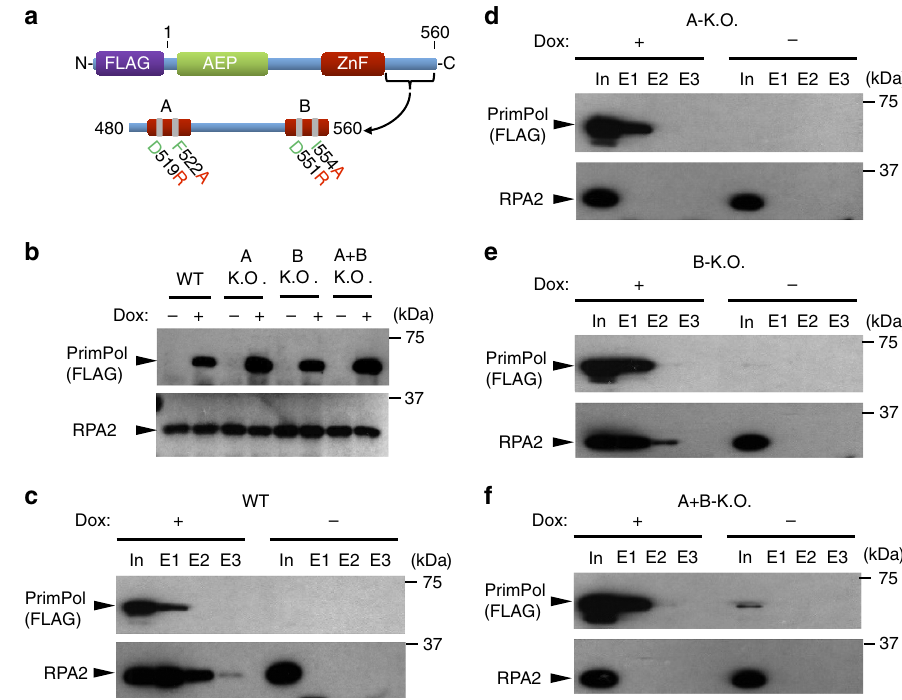
Figure 4 | PrimPol RBM-A is critical for RPA-binding in vivo . ( a ) Schematic detailing the domain architecture of N-terminal FLAG-tagged PrimPol transfected into HEK-293 derivative cells (Flp-In T-Rex-293). The RBD (480–560) containing the RBM-A and B sites is shown below with the mutations forming the A-KO (D519R and F522A) and B-KO (D551R and I554A) highlighted. ( b ) Flp-In T-Rex-293 cells were transfected with wild-type and RBM-A and B mutated PrimPol. Expression was confirmed by addition of 10ngml (cid:2) 1 doxycycline (indicated by Dox ± on figure) for 24h and subsequent western blotting. ( c ) Flp-In T-Rex-293 cells transfected with FLAG-tagged wild-type (WT) PrimPol were grown in the presence or absence of doxycycline (10ngml (cid:2) 1 , 24h), FLAG-PrimPol was immunoprecipitated from the soluble cell lysate using anti-FLAG antibody and western blotted for PrimPol (anti-FLAG) and RPA (anti-RPA2). The presence and absence of doxycycline is indicated by ± Dox, ‘In’ indicates the input, ‘E1’, ‘E2’ and ‘E3’, indicate elutions 1, 2 and 3, respectively. ( d ) Immunoprecipitation of FLAG-PrimPol A-KO (D519R/F522A) from Flp-In T-Rex-293 cells grown in the presence and absence of doxycycline. ( e ) Immunoprecipitation of FLAG-PrimPol B-KO (D551R/I554A) from Flp-In T-Rex-293 cells grown in the presence and absence of doxycycline. ( f ) Immunoprecipitation of FLAG-PrimPol A þ B-KO (D519R/F522A and D551R/I554A) from Flp-In T-Rex-293 cells grown in the presence and absence of